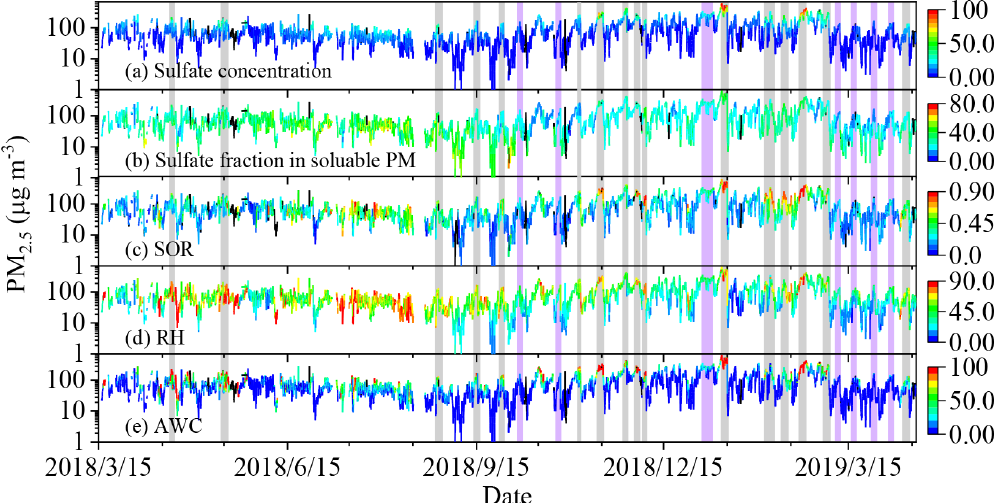
Figure 2. Mass concentration of PM 2 . 5 colored according to (a) sulfate concentration, (b) sulfate fraction in soluble PM, (c) SOR, (d) RH and (e) AWC in Shijiazhuang. The shade areas in grey indicate the pollution events with high concentration of sulfate at high RH, while the purple ones the mean pollution events with low sulfate fraction at high